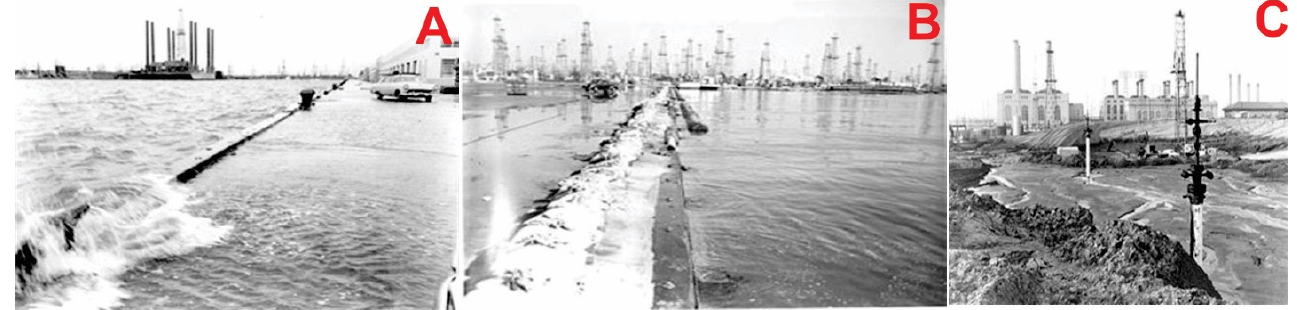
Figure 3. (A , B ) Seawater rushes over the mainland in the Long Beach area, California, ( C ). Water injections [57] .